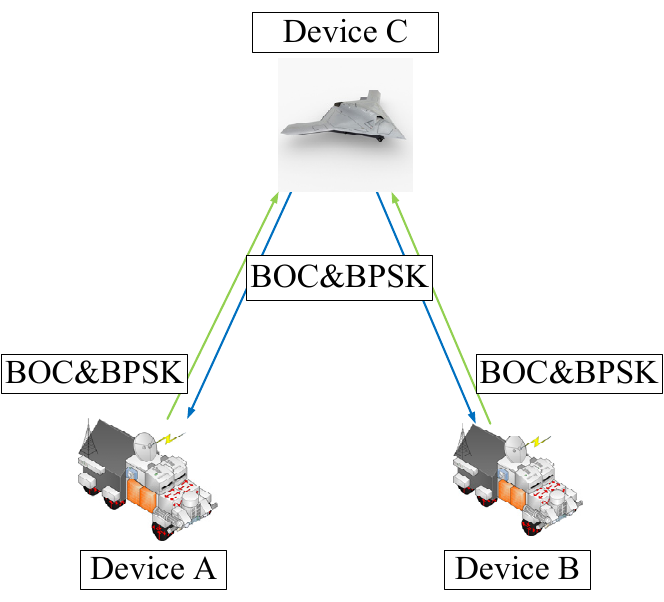
Figure 6. The application scenario.